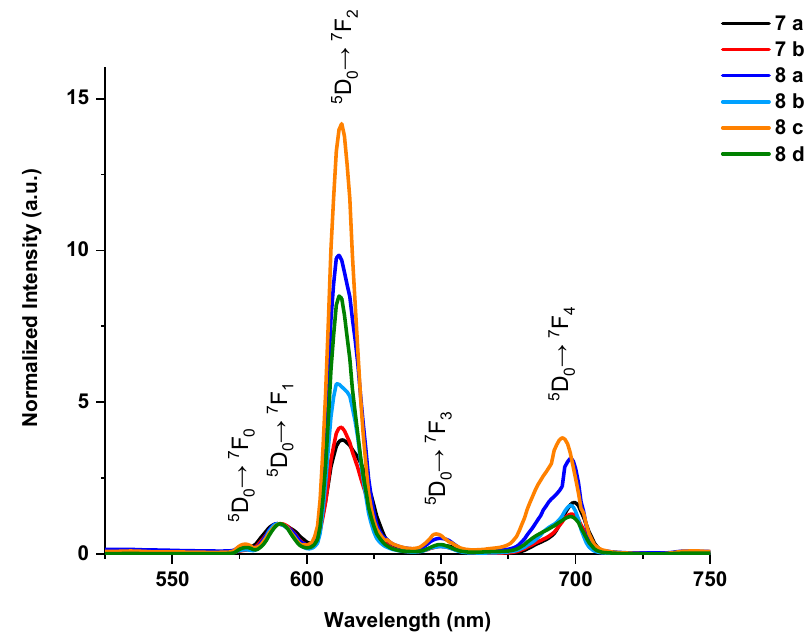
Figure 12. Emission spectra of compounds 7 a , b and 8 a – d in the solid state normalized at the 5 D 0 → 7 F 1 transition; excitation at 300 nm .